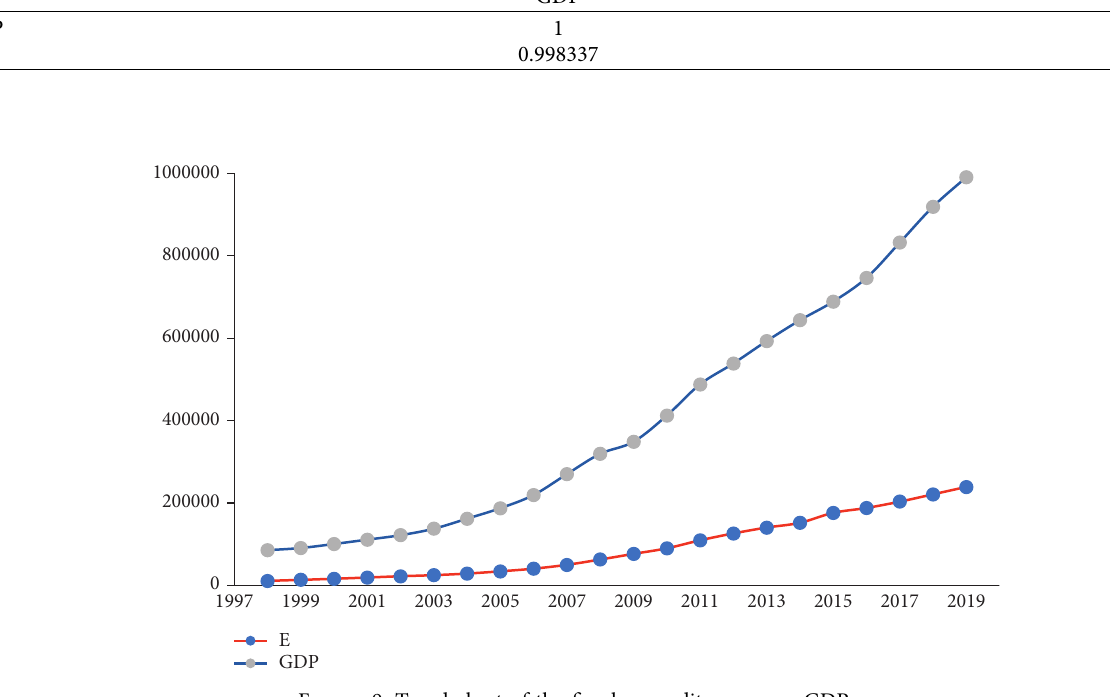
Figure 9: Trend chart of the fiscal expenditure versus GDP.